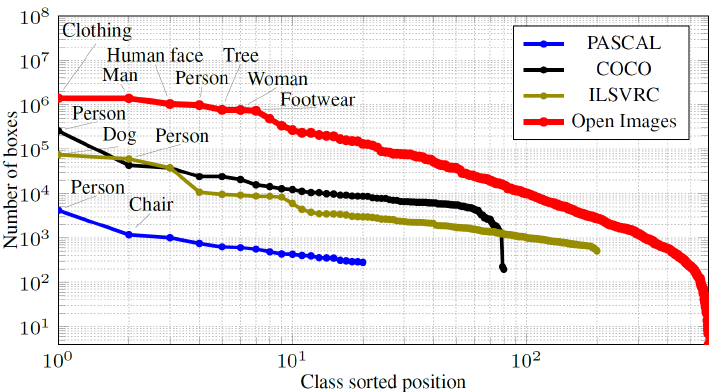
Figure 8. The number of annotated boxes per class in four common datasets. The horizontal axis is represented in logarithmic scale for better readability.